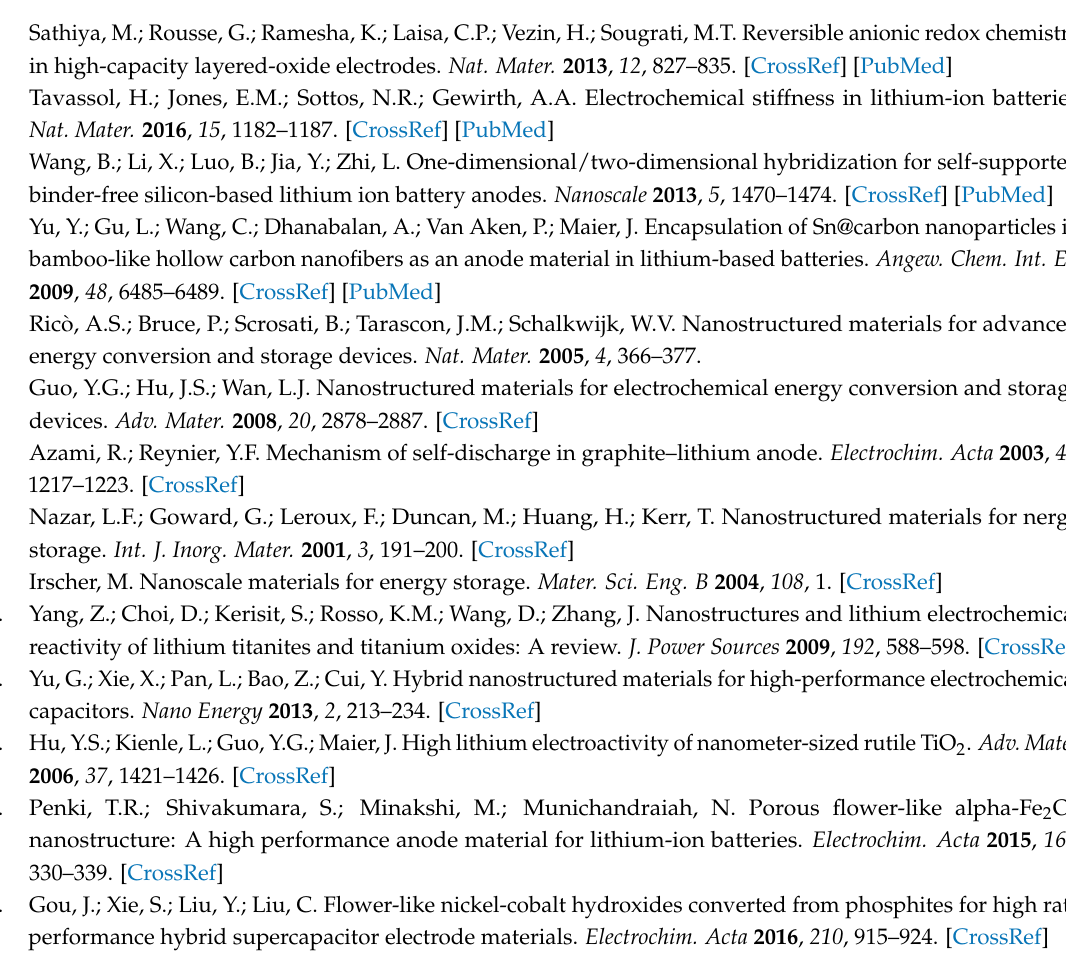
Figure S1: XRD patterns: Fe-based precursor (a) and flowerlike α -Fe 2 O 3 (b), Figure S2: High-resolution SEM image of flowerlike Fe-based precursor, Figure S3: The high-resolution SEM image of α -Fe 2 O 3 in the rectangular region shown in Figure 2b, Figure S4: The high-resolution SEM image of 3D F-FeS in the rectangular region shown in Figure 2c, Figure S5: The high-resolution SEM image of 3D F-FeS in the rectangular region shown in Figure 2d, Figure S6: EDS elemental mapping showing the homogenous distribution of Fe and S elements in B-FeS nanostructure, Figure S7: Nitrogen adsorption–desorption isotherms of B-FeS, Figure S8: Pore size distribution curve of as-prepared B-FeS, Figure S9: XPS spectra for the as-prepared B-FeS nanostructure: (a) Fe 2p and (b) S 2p spectra, Figure S10: CV curves of B-FeS at a scan rate of 0.1 mV s − 1 , Figure S11: Corresponding galvanostatic discharge/charge at various current densities for B-FeS electrode, Figure S12: Long-term cyclic performance of B-FeS at the current density of 1.0 A g − 1 , Figure S13: Electrochemical impedance spectra and equivalent circuit of 3D F-FeS and B-FeS nanostructures electrodes after cycling. A sine wave with amplitude of 10.0 mV over the frequency range from 100 kHz to 10 mHz, Figure S14: SEM image of 3D F-FeS electrode at full-charge state (3.0 V) after cycling at a current density of 0.1 A g − 1 , Table S1: Comparison with previous reports, Table S2: Impedance parameters obtained using equivalent circuit model for 3D F-FeS and B-FeS nanostructure